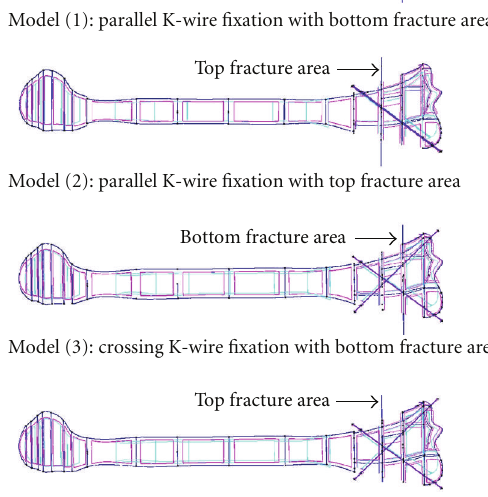
Figure 8: Four wire frame models to model the two types fracture areas.